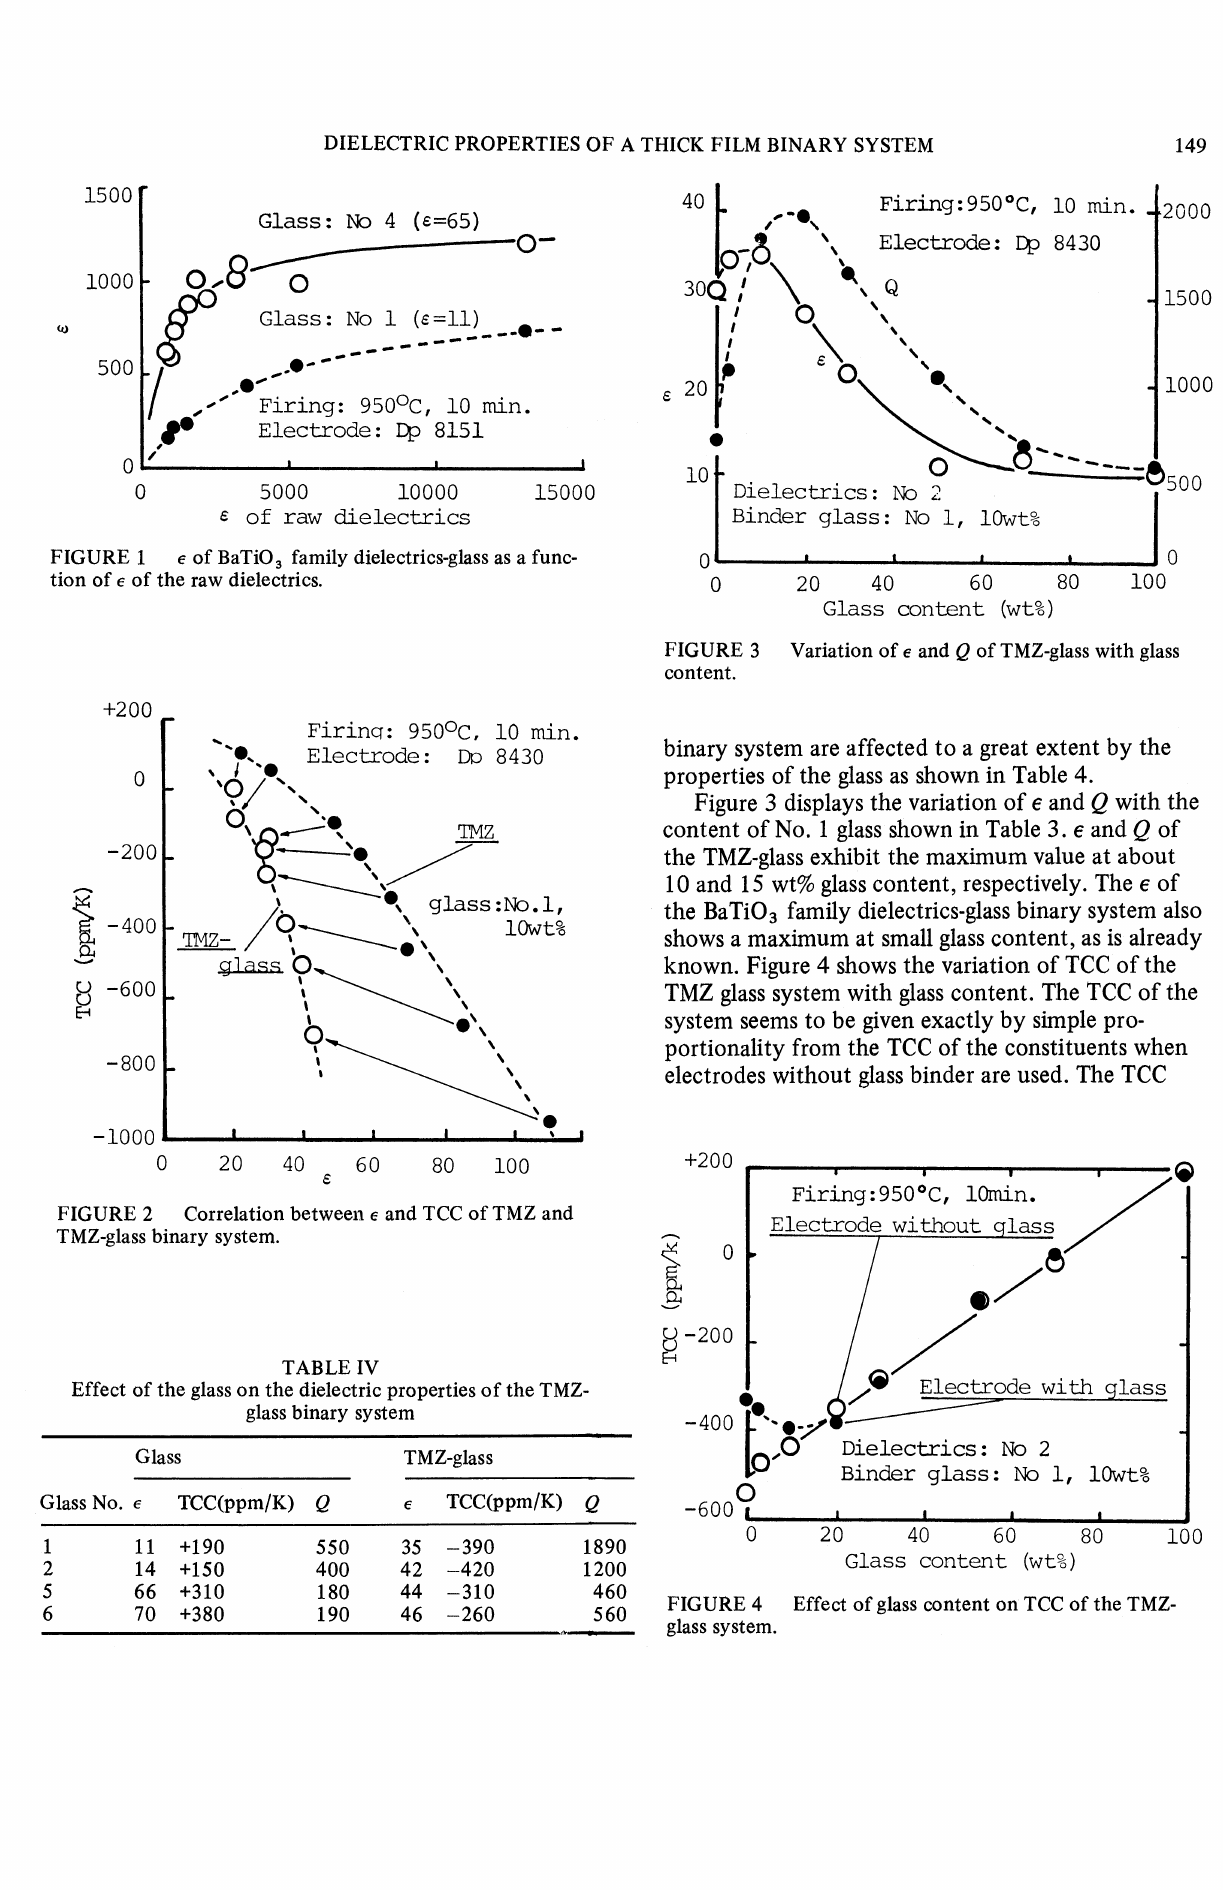
Effect of glass content on TCC of the TMZ- glass